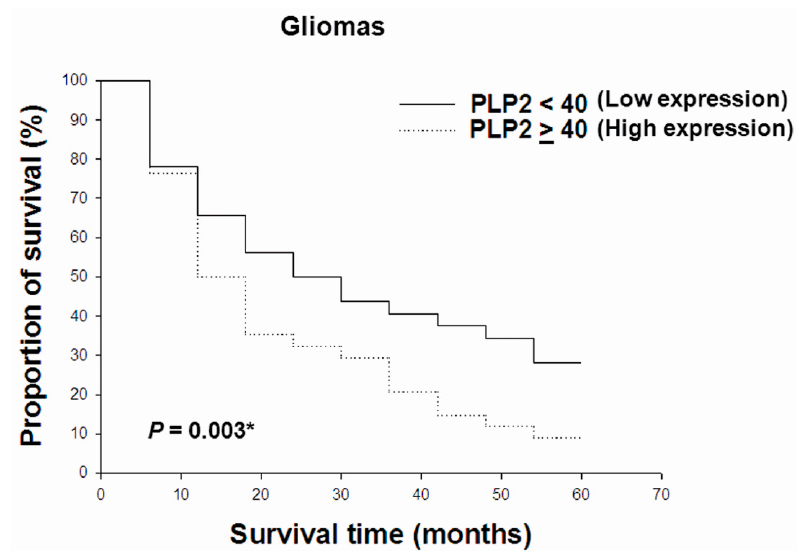
Figure 3. Hematoxylin and eosin staining of ( A ) normal brain tissue, ( B ) pilocytic astrocytoma, ( C ) diffuse astrocytoma, ( D ) anaplastic astrocytoma, and ( E ) glioblastome multiforme. IHC analysis of PLP2 in ( F ) normal brain tissue, ( G ) pilocytic astrocytoma, ( H ) diffuse astrocytoma, ( I ) anaplastic